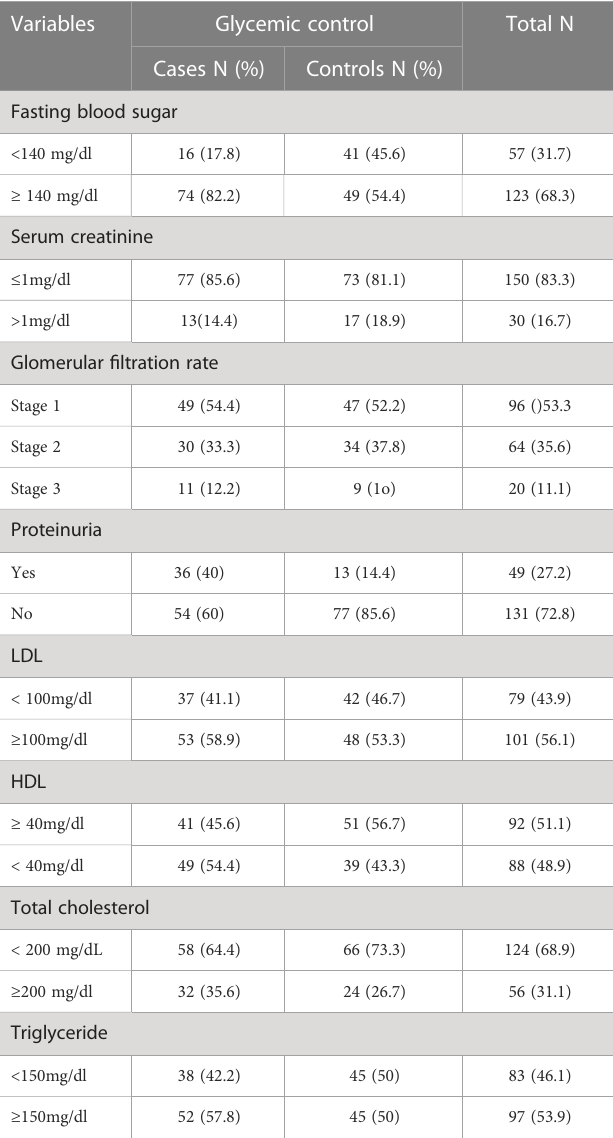
Table 5 Biochemical parameters of type 2 diabetes mellitus at DM clinic of UOGCSH, Northwest Ethiopia, 2020 (N=180). Variables